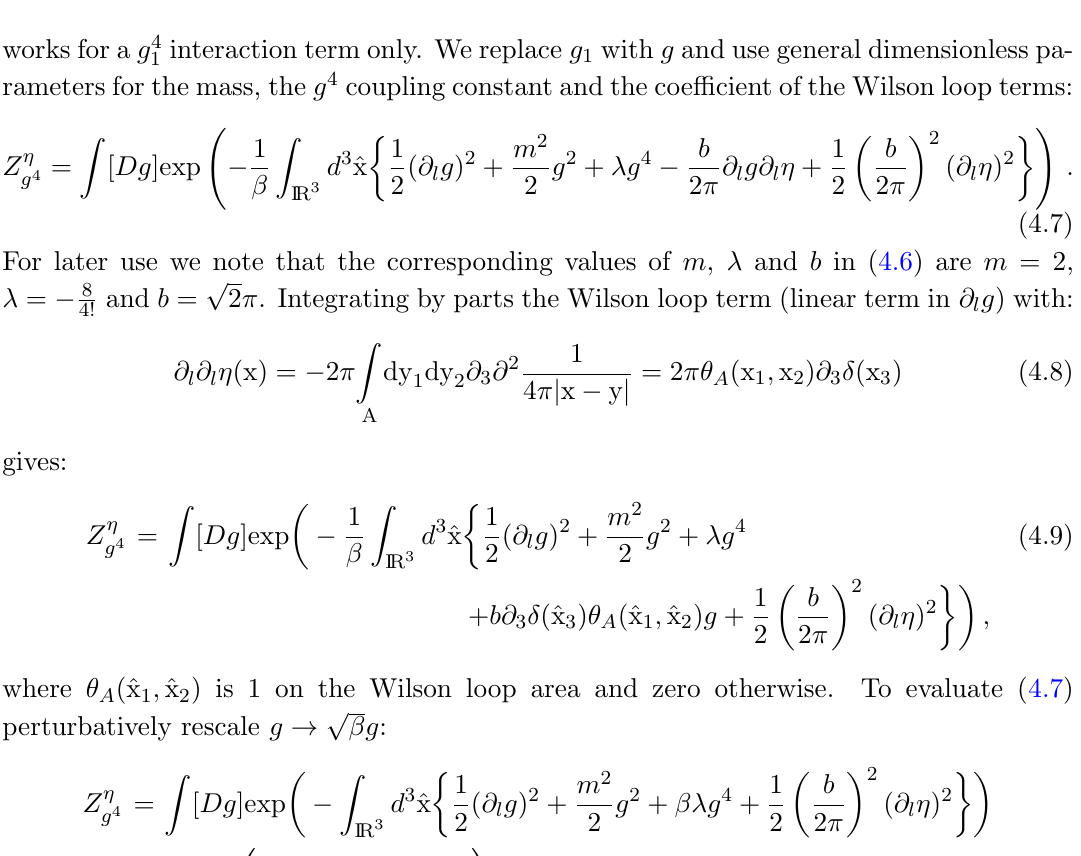
Table 3 . Comparison of N -ality 1 k -string tensions for SU(2 perturbative method explained here | leading contribution a 1 plus (cid:12)rst subleading a 2 (cid:21) , from eq. (4.5) | with the results of the numerical study. To avoid confusion, we note that the exact analytic values for SU(2) and SU(3) in the dimensionless units used here are 8 and 9 : 238, respectively which agree with the numerical values listed in appendix D; see also the end of section